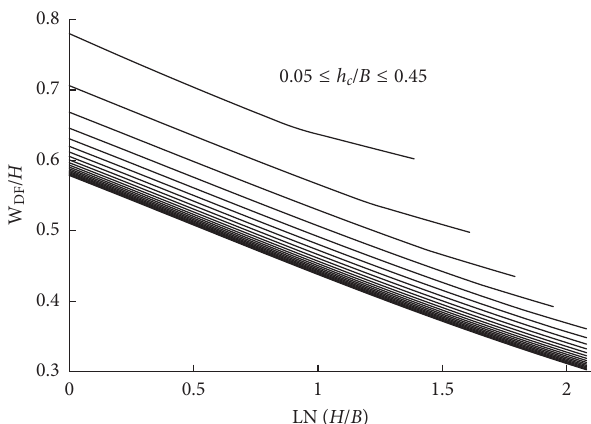
Figure 15: Coefficient change schematic diagram of structure directional collapse influence